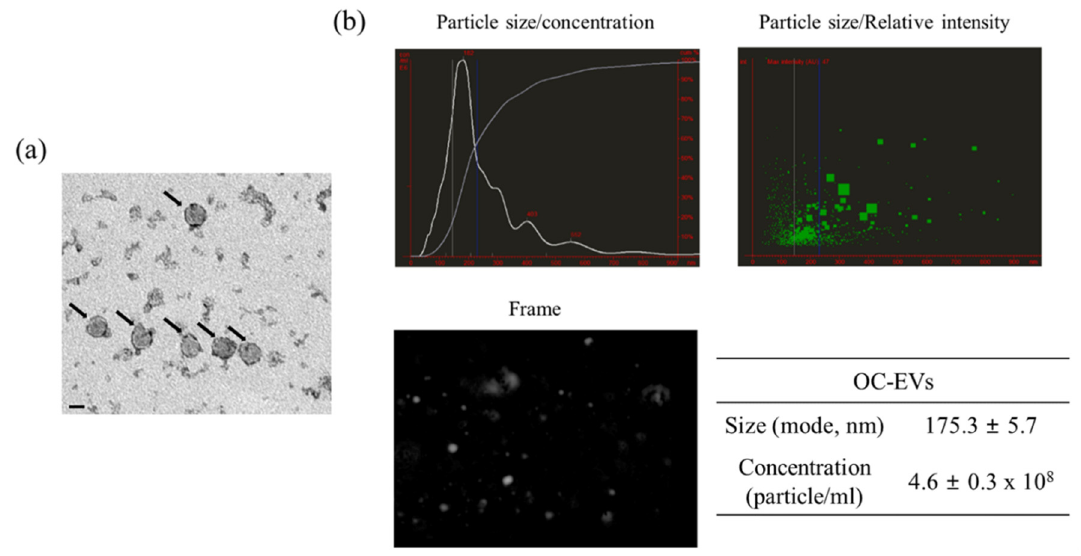
Figure 1. Characterization of canine OC-EVs. ( a ) Morphological characterization of EVs isolated from in vitro cultured oviduct cells using transmission electron microscopy (Scale bar = 100 nm). Black arrows indicate EVs. ( b ) Characterization of EVs regarding particle size, concentration, and relative intensity using a nanoparticle tracking analysis (NTA). Data are shown as means ± standard error of the mean. OC-EVs: canine in vitro oviductal cell-derived extracellular vesicles.